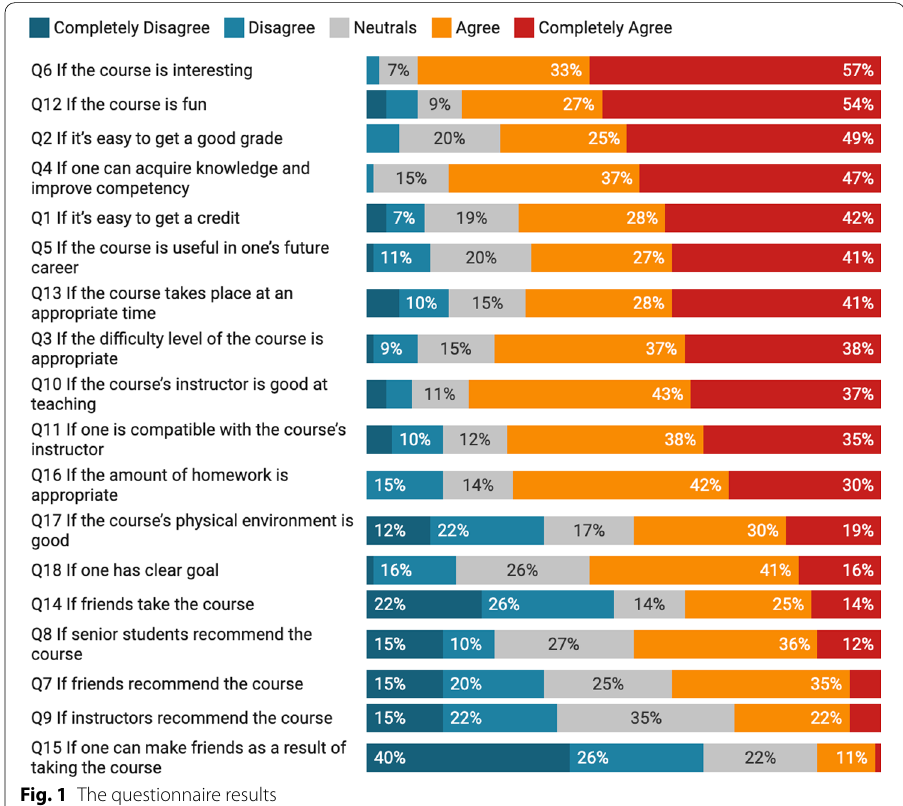
Fig. 1 The questionnaire